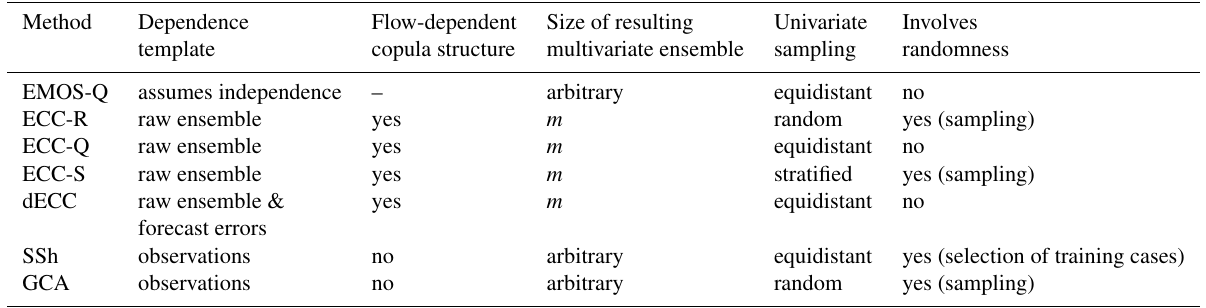
Table 1. Overview of selected key characteristics of the multivariate post-processing methods considered in this paper. Method Dependence Flow-dependent Size of resulting Univariate Involves template copula structure multivariate ensemble sampling